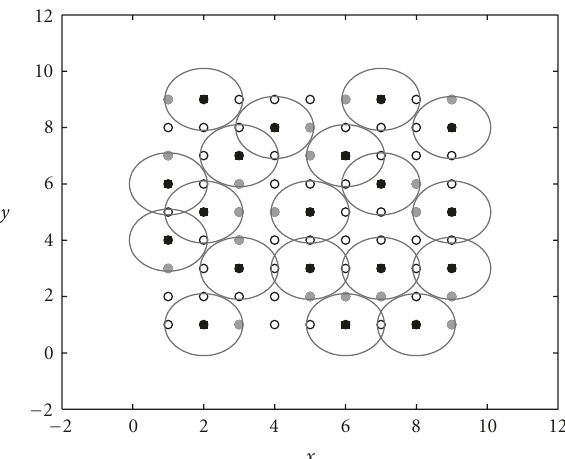
Figure 4: A snapshot of concurrent cochannel transmissions determined by the D-SAM protocol for a network in a regular square grid. R = d a , M = 8, and ζ = 1 were used, where d a is the minimum distance between two adjacent nodes. The black nodes are the receiving nodes, and the grey nodes are the transmitting